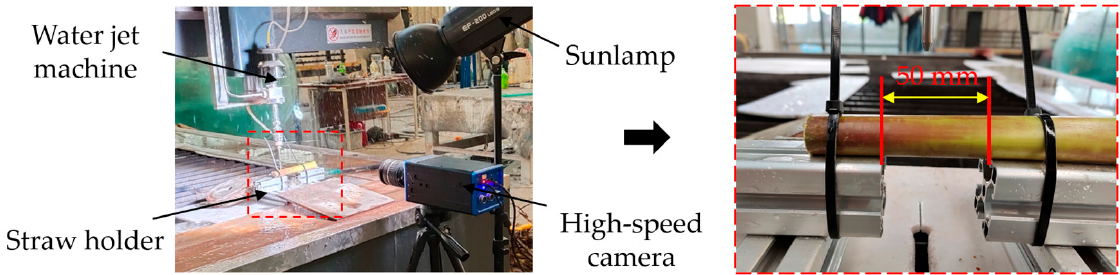
Figure 3. The bench for water jet cutting experiments.